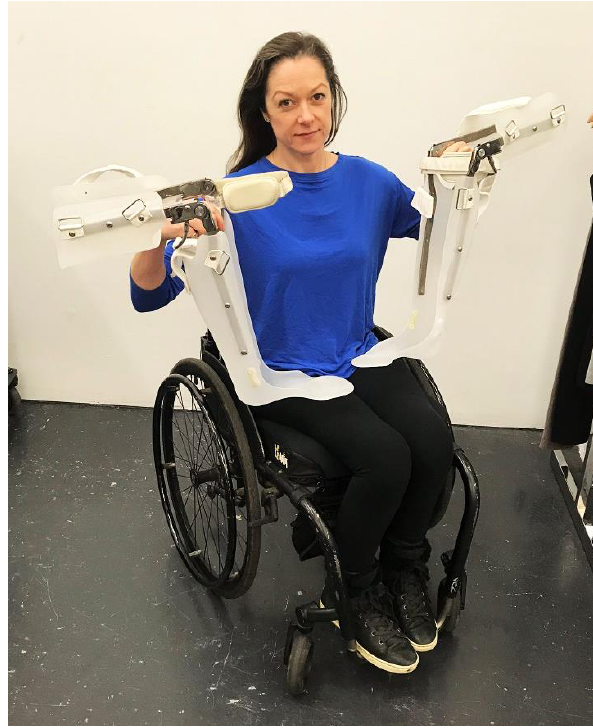
Figure 1: The second lowest day of my life. The day after I walked in a wearable robotic suit from the future, the rehab centre’s exoskeleton, I found myself in the basement of a hospital being fit for leg braces made of metal rods and leather straps that looked like they came out of a history book. The contradiction made me second guess my own sanity. Was I in 1950? How did I get here and how do I get back to the